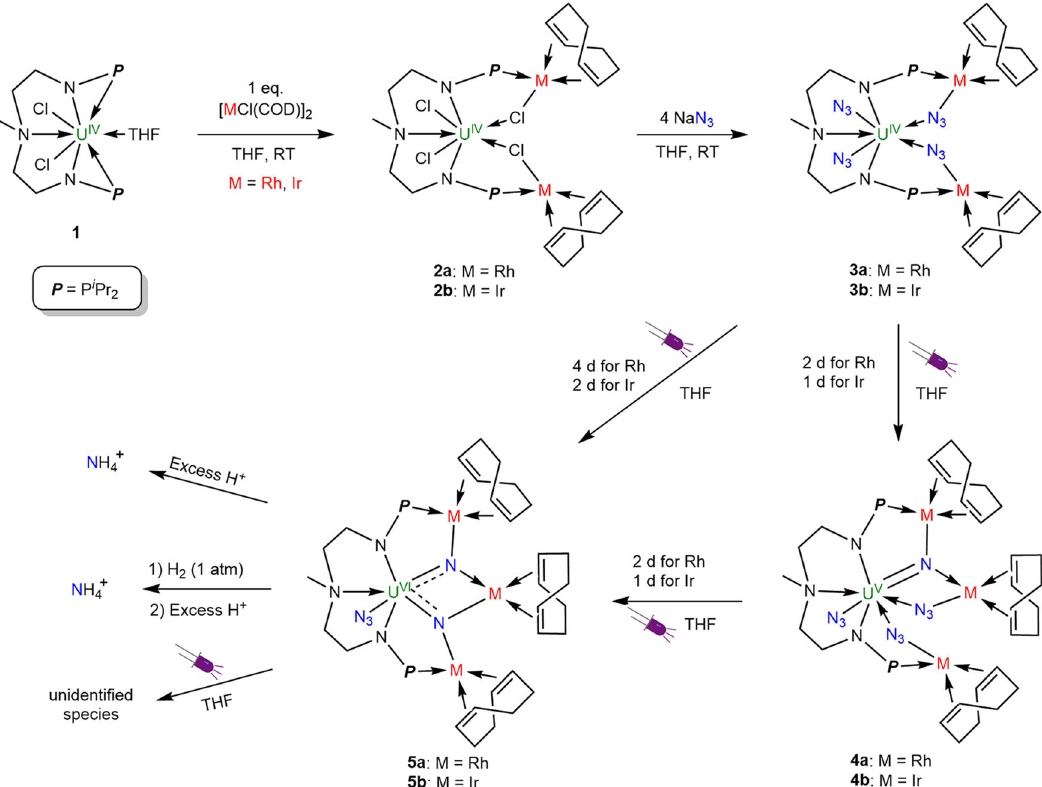
Fig. 2 Synthesis and reactivity of complexes 2, 3, 4, and 5. Complexes 3a and 3b with four azides were prepared by the reaction of complexes 2 with NaN 3 . By careful control of the irradiation time of complexes 3 , the U(VI) nitrides 5 were formed via the U(V) nitrides intermediates 4 . The nitride groups in complexes 5 react with acid or H 2 /acid to form NH 4 + in good yield. The N atoms originating from N 3 − are shown in blue and transition metals (M) are shown in